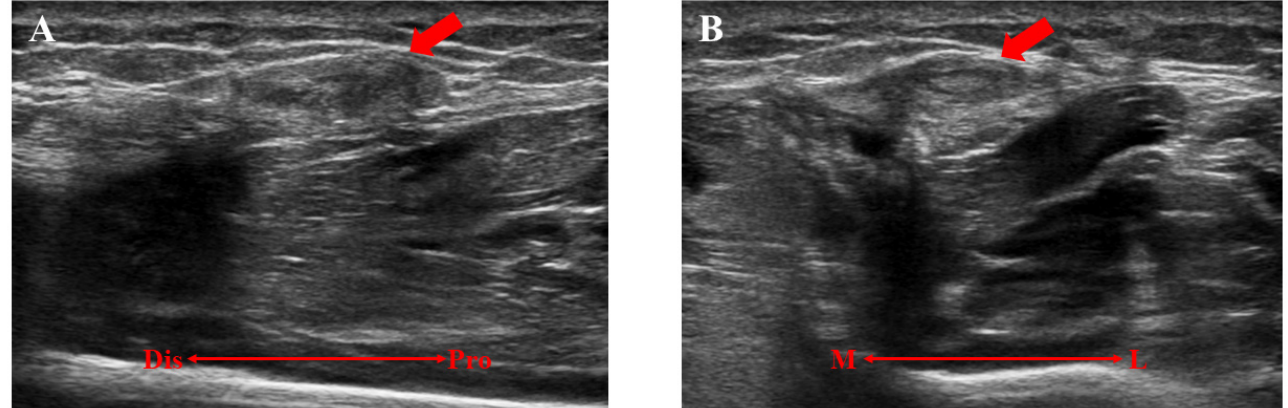
Figure 5. The ultrasonographic findings of the traumatic neuroma of the superficial peroneal nerve (12 × 8 mm) (red arrow). ( A ) A long-axis view. ( B ) A short-axis view. Dis, distal; Pro, proximal; M, medial; L, lateral.